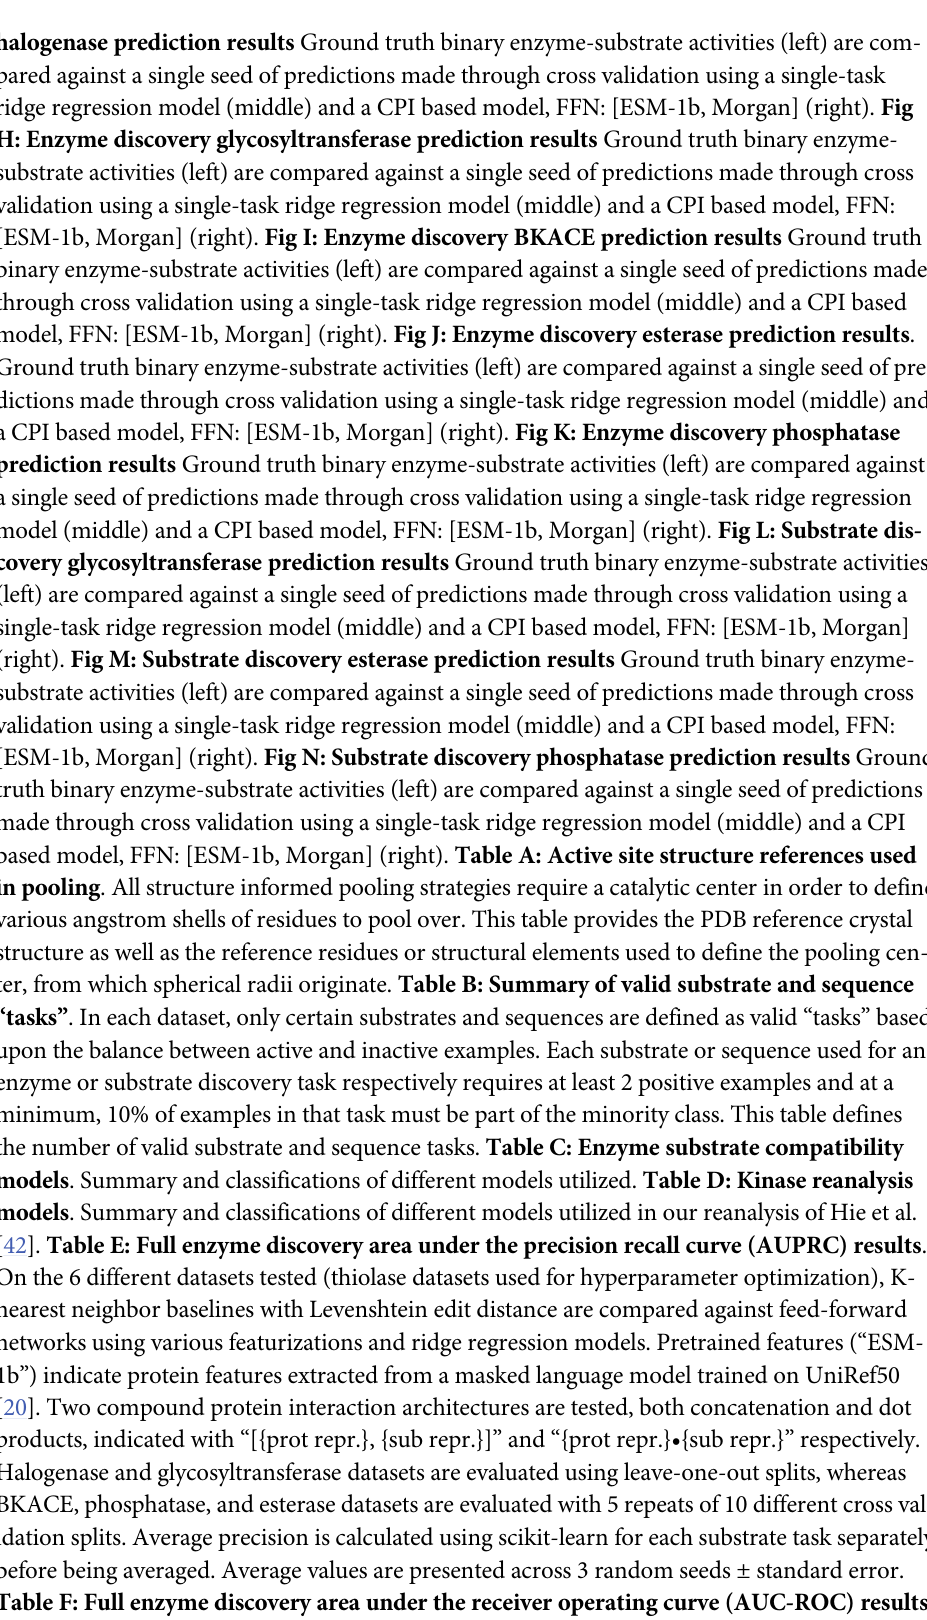
Table F: Full enzyme discovery area under the receiver operating curve (AUC-ROC) results